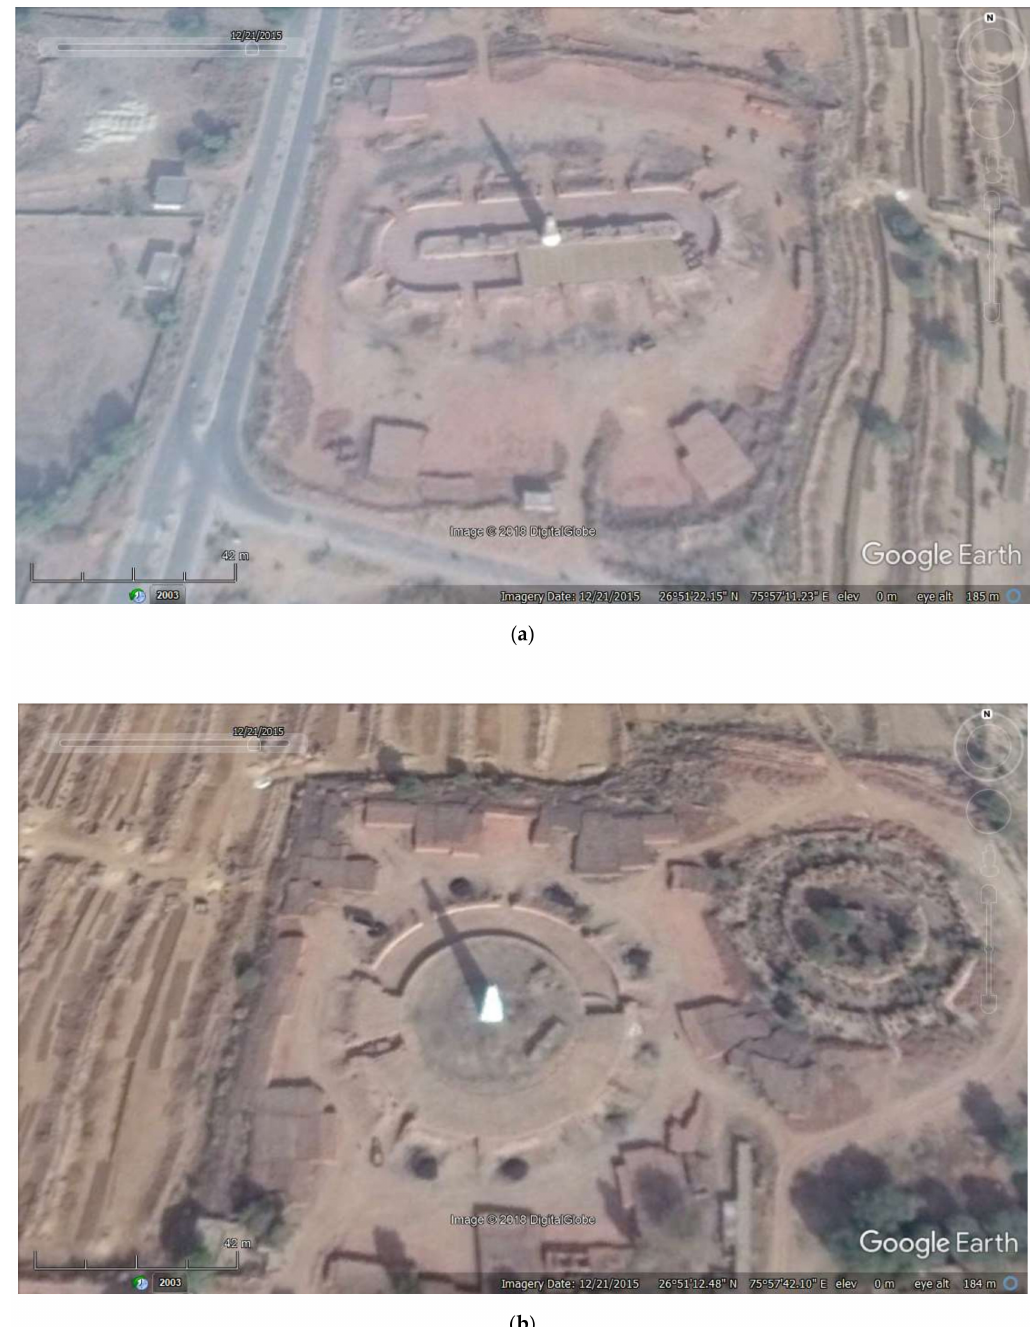
Figure 1. Examples of brick kilns in the test site. ( a ) Oval and ( b ) circular. Note in ( b ) what appears to be an abandoned